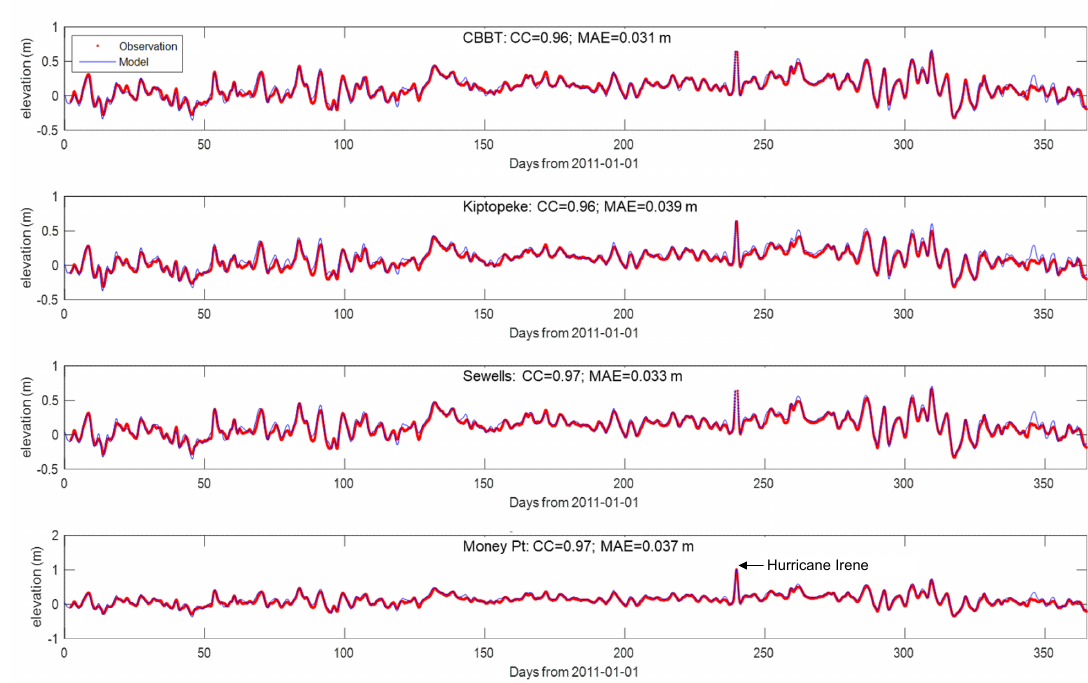
Figure 6. Model-data comparison on the sub-tidal surface elevation at four stations near the project site.